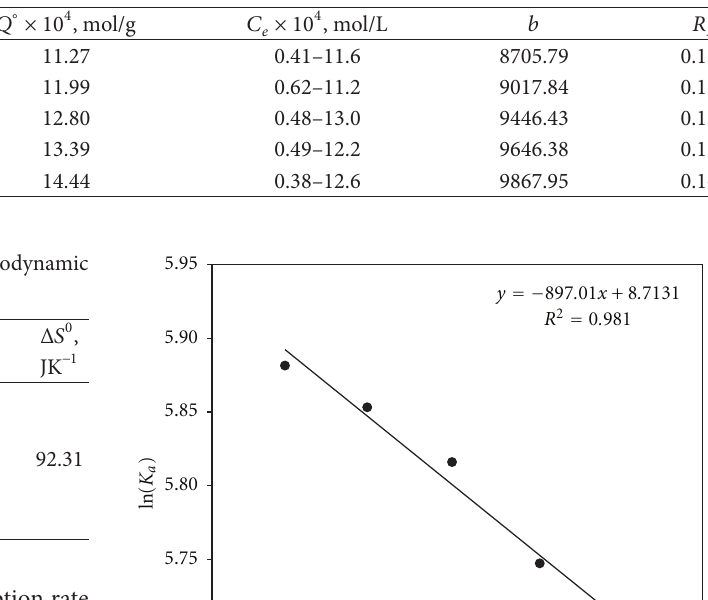
T 3: Effect of temperature on adsorption capacity and Langmuir constant.